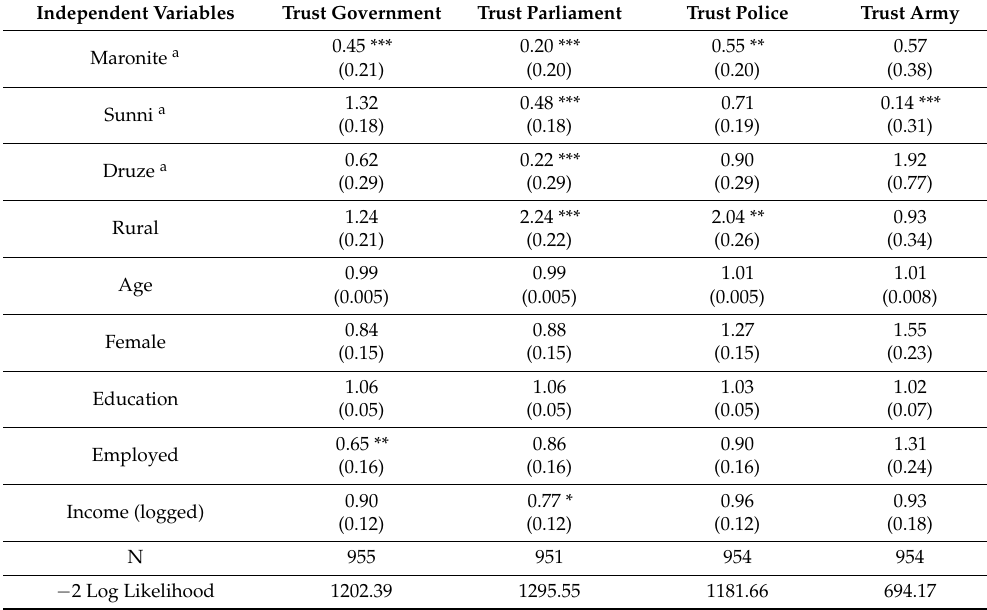
Table 7. Estimated Odds Ratios for Trust in